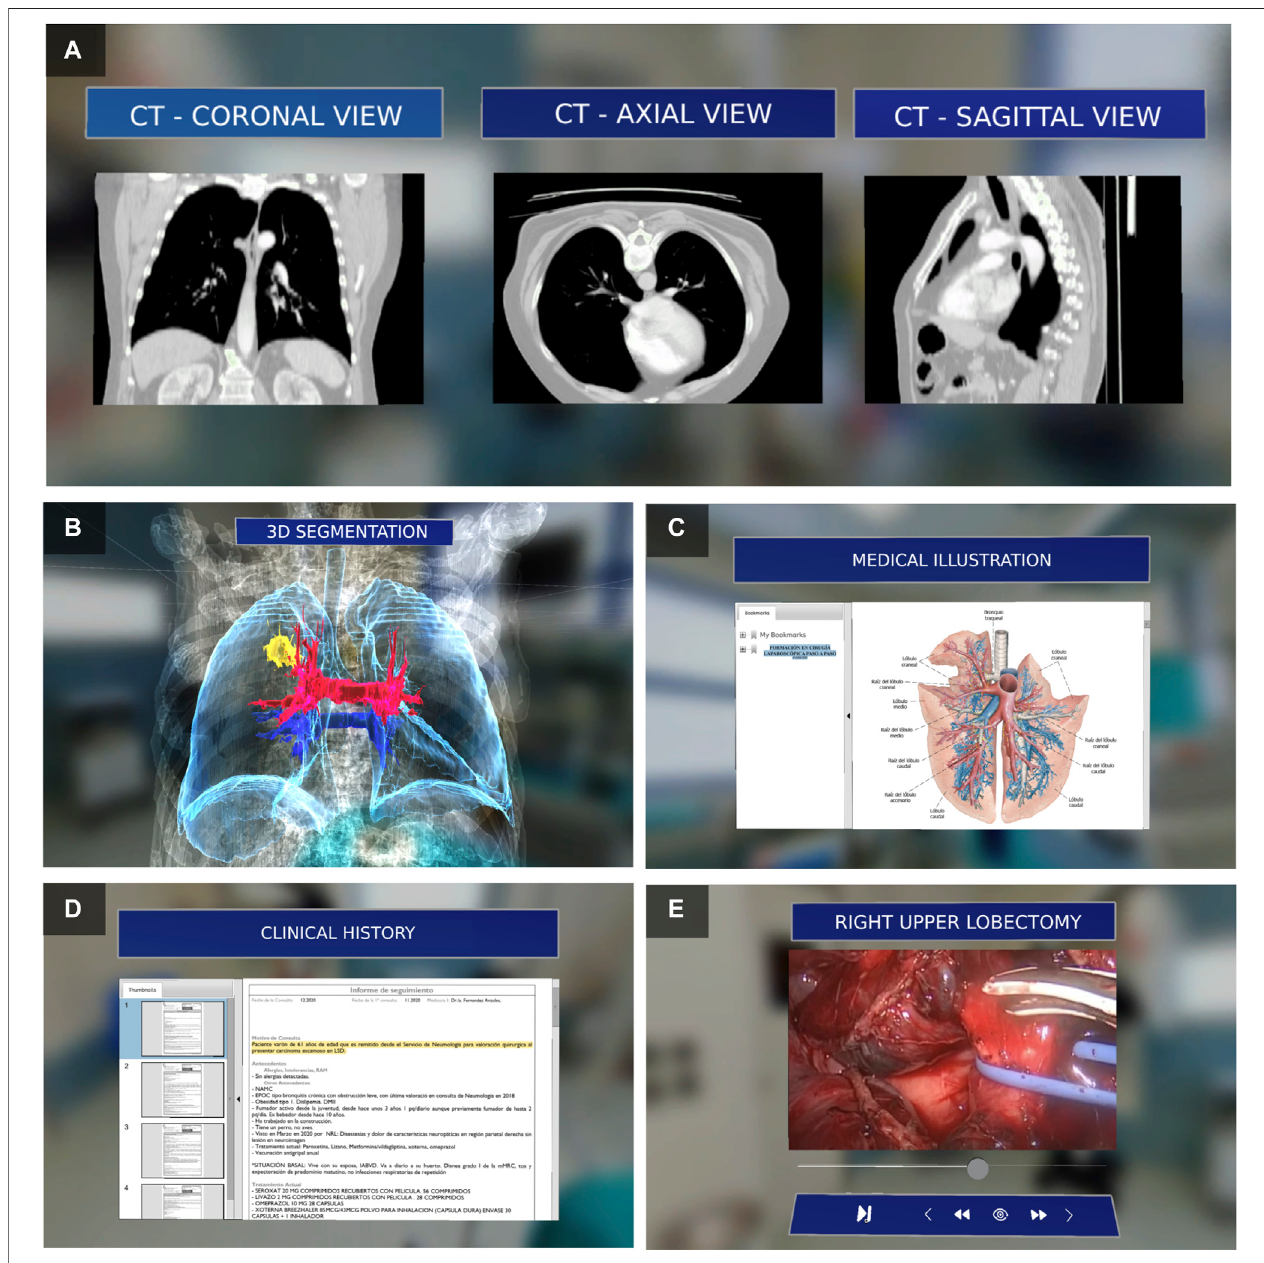
FIGURE2| Assistance contentforsurgicalplanning: (A) viewsofthepreoperativeimagingstudy, (B) 3D anatomicalmodel ofthepatient, (C) medical illustration of the anatomy to be addressed during surgery, (D) medical history of the patient, and (C) reference video of the surgical procedure.